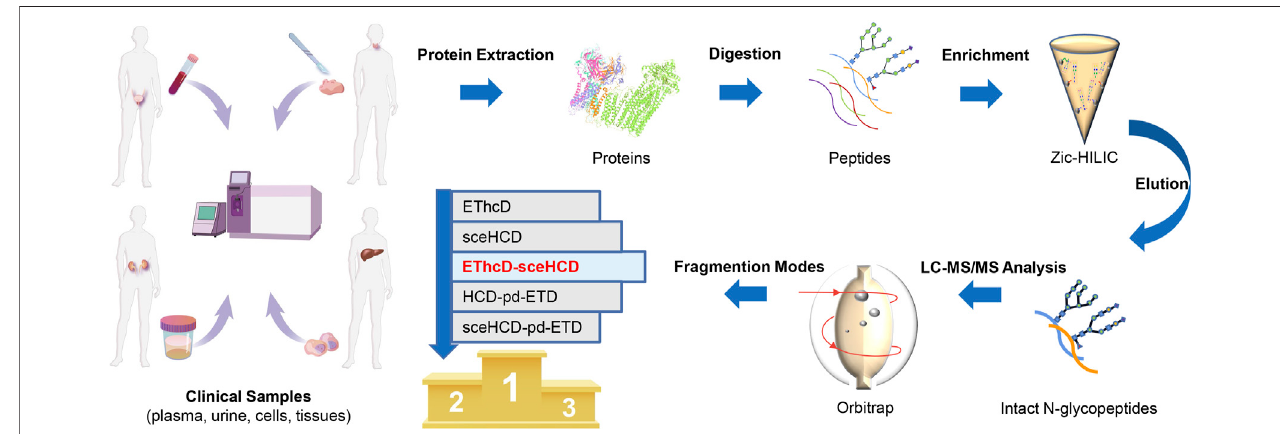
FIGURE 1 | Schematic illustration of the work fl ow for human plasma, urine, cells, and tissue intact N-glycopeptides analysis using different dissociation